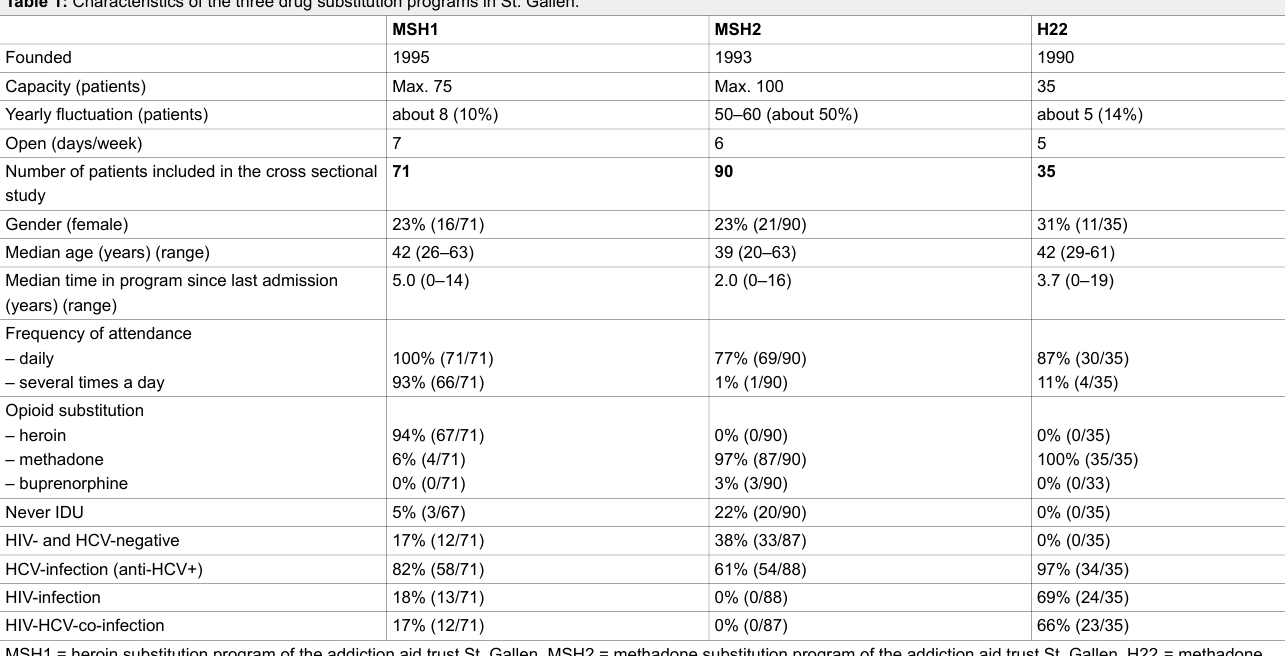
Table 1: Characteristics of the three drug substitution programs in St. Gallen. MSH1 MSH2